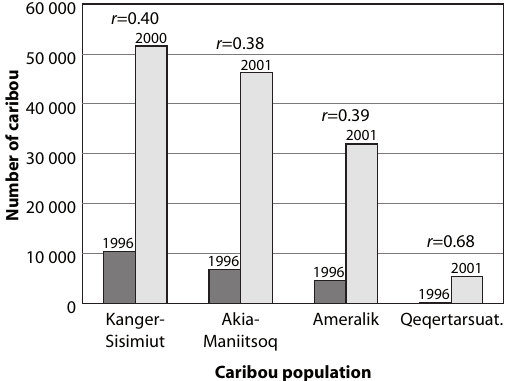
Fig. 7. Caribou abundance and calculated actual rates of increase “ r ” for four herds in West Greenland from 1996 to